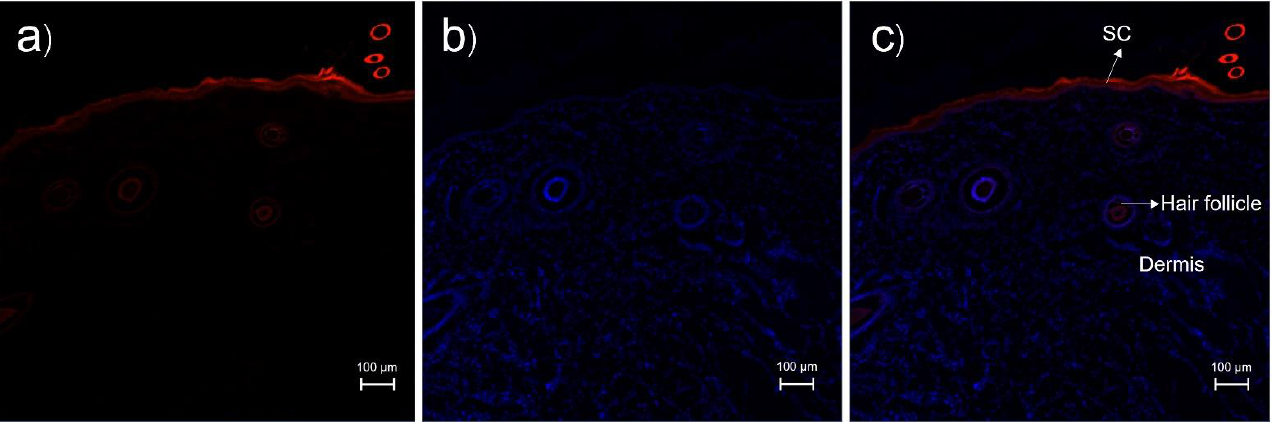
Figure 4. CLSM images of cross-sectioned pig skin treated with rhodamine B base solution and stained with DAPI at 1 h: ( a ) red fluorescence from rhodamine B base; ( b ) blue fluorescence from DAPI; ( c ) merged image of ( a ) and ( b ). The scale bar represents 100 µm. SC = stratum corneum.